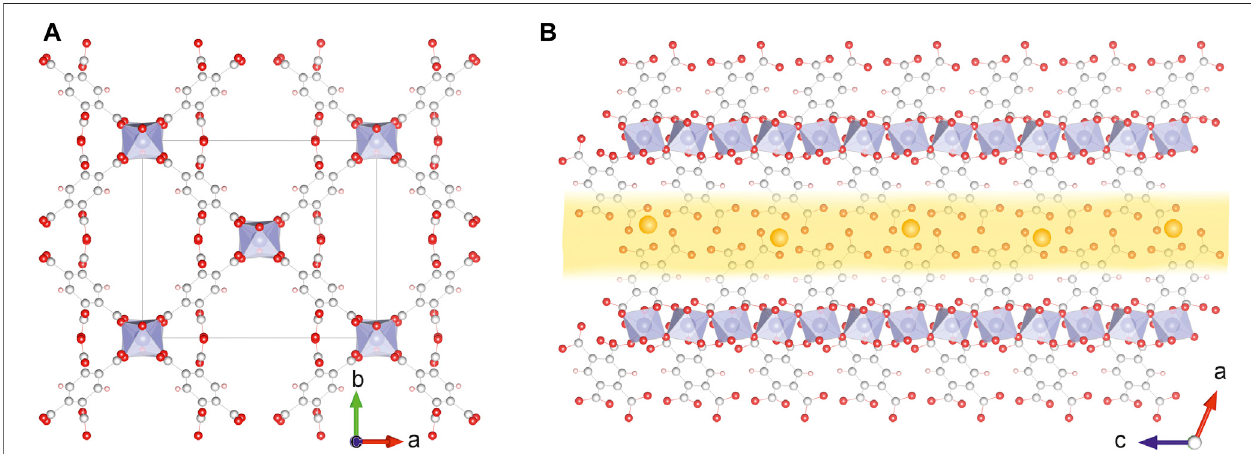
FIGURE 1 | (A) The MIL-121 unit cell viewed along the crystallographic c-direction and drawn with the pores empty and fully opened. The protons of carboxylic units are omitted for the sake of clarity. (B) Section along one channel, extended for 6 unit cells in the c-direction, illustrating the in fi nite aluminium octahedra chains, the approximate lumen of the linear pore (yellow shade) and the free carboxylic units lining the pores where the ion exchange with Li + (large spheres) occurs. The protons of the carboxylic groups are omitted.